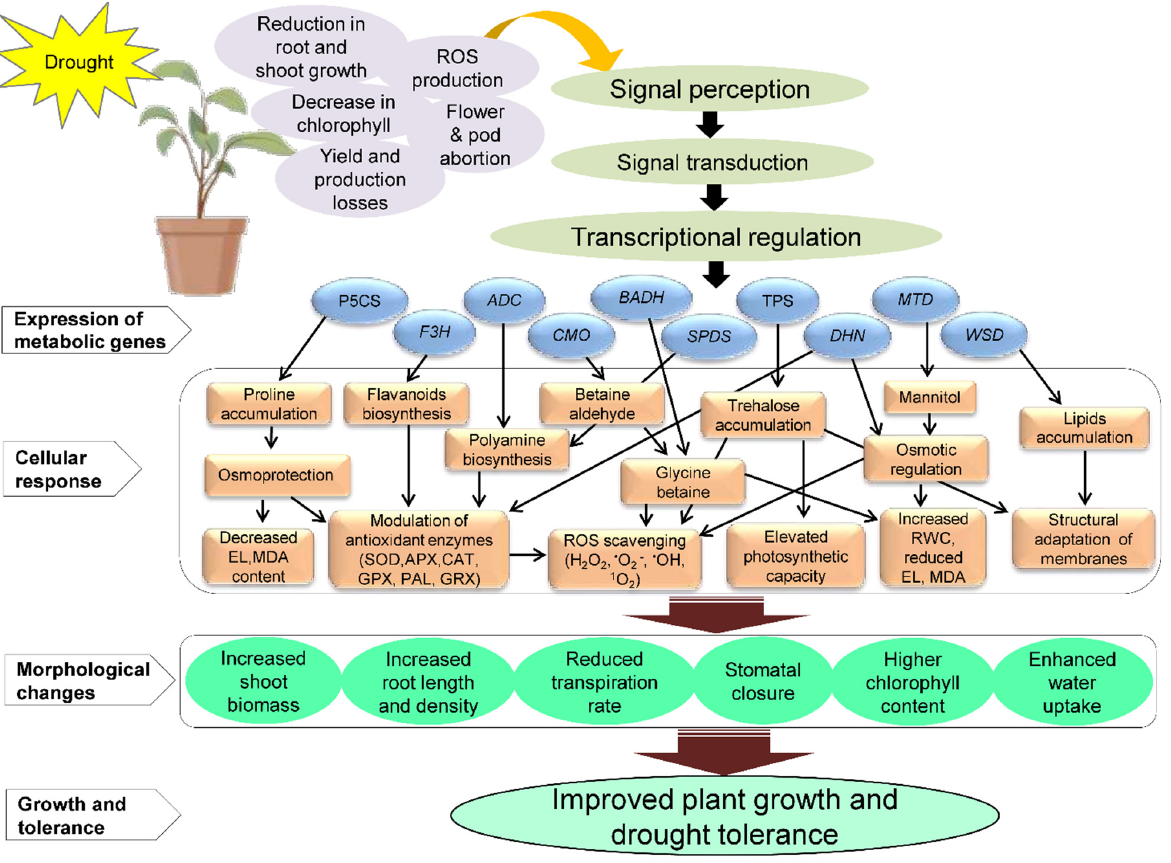
Figure 2. Schematic model displaying drought-induced expression of metabolic genes in transgenic plants. The proposed model depicts drought stress (DS)-mediated (yellow circle) reduction in root and shoot biomass, decrease chlorophyll content, increased reactive oxygen species (ROS) and flower and pod abortion, reducing yield and production (shown in purple oval). Plant DS response and adaptation involve various pathways for signal perception, transduction, tran- scriptional regulation depicted in olive green ovals, and expression of various metabolic genes shown in aqua color rectangle. Drought-induced expression of metabolic genes, such as ∆ 1-pyrroline-5-carboxylate synthetase (P5CS) , trehalose- 6-phosphate synthase1 (TPS1) , dehydrin (DHN), cysteine protease (CP), flavanone 3-hydroxylase (F3H), arginine decarboxylase gene (ADC), choline monooxygenase (CMO), betaine aldehyde dehydrogenase (BADH), and spermidine synthase (SPDS ), mannitol dehydrogenase (MTD) , wax synthase/acyl-CoA:diacylglycerol acyltransferase (WSD) resulted in the accumulation of primary and secondary metabolites. This leads to the accumulation of several osmoprotectants and defensive compounds and ROS detoxification inside cells. Modulation of antioxidants prevents cell damage and maintains homeostasis. SOD, superoxide dismutase; CAT, catalase; APX, ascorbate peroxidase; GPX, guaiacol peroxidase; PAL, phenylalanine ammonia-lyase; GRX, glutaredoxins; MeJA, methyl jasmonate; GB, glycine betain; SA, salicylic acid depicted in orange color rectangles. Morphological changes occurs in plants are shown in light green color rectangles. Plant growth and tolerance are shown in light green color in rectangle. Figure adapted from images created with BioRender.com to draw the proposed model (https://app.biorender.com/biorender-templates (accessed on 18 June